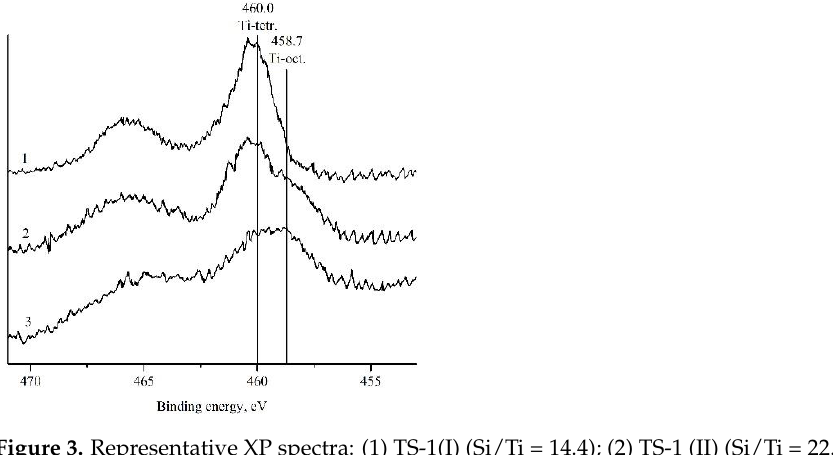
Figure 3. Representative XP spectra: (1) TS-1(I) (Si/Ti = 14.4); (2) TS-1 (II) (Si/Ti = 22.9); (3) TS-1(III) (Si/Ti = 32).